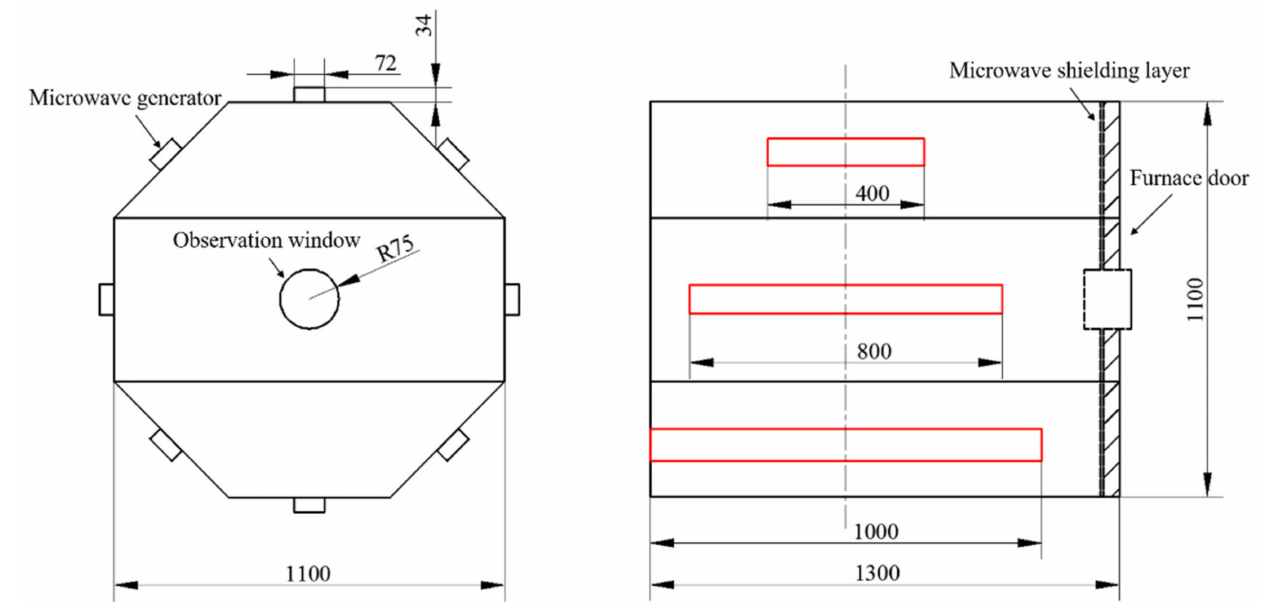
Figure 4. Arrangement of the microwave